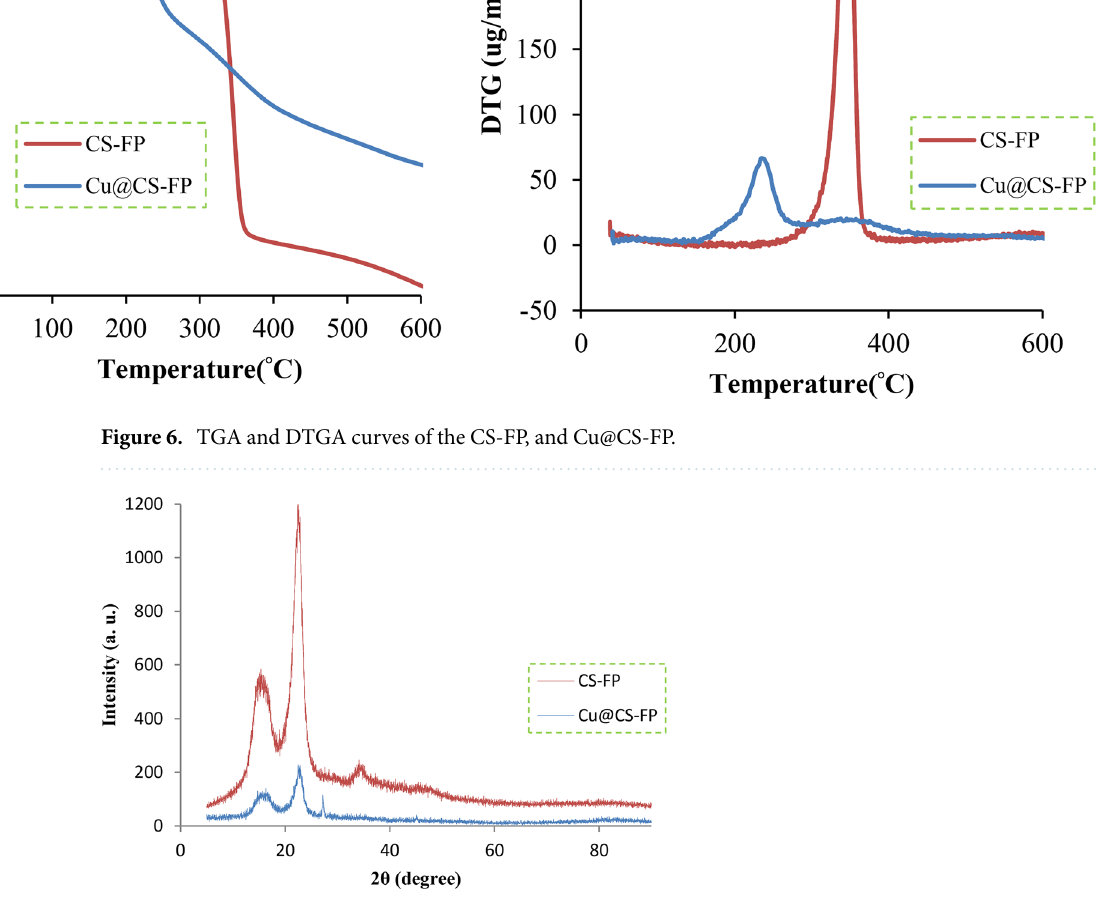
Figure 7. XRD patterns of the CS-FP, and Cu@CS-FP.